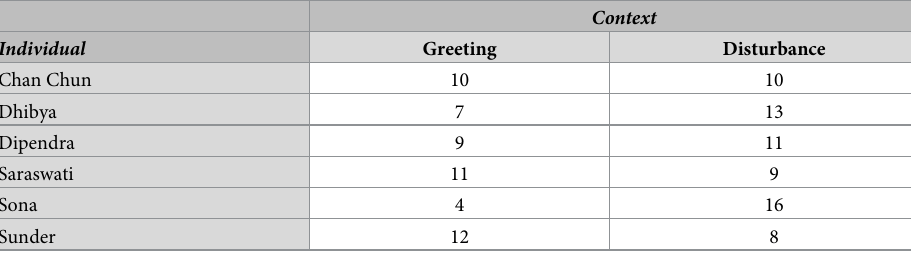
Table 3. Number of trumpets per individual and context included into statistical